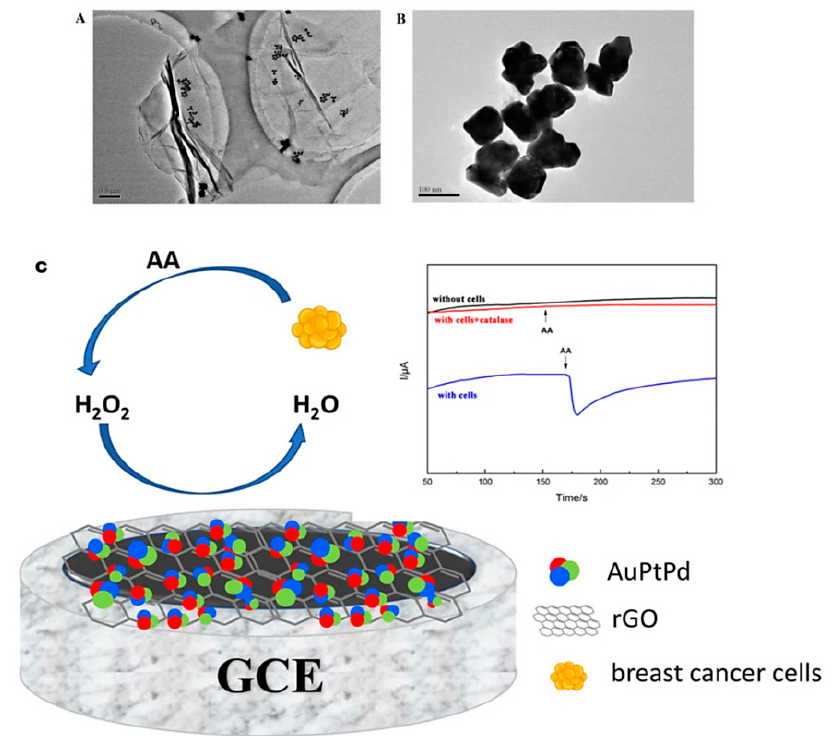
Figure 14. ( A , B ) TEM images of varying magnifications of AuPtPd / rGO. ( C ) AuPtPd / rGO-modified GCE employed for identifying H 2 O 2 released from cells. Reproduced from [39], with permission from Elsevier, 2018.